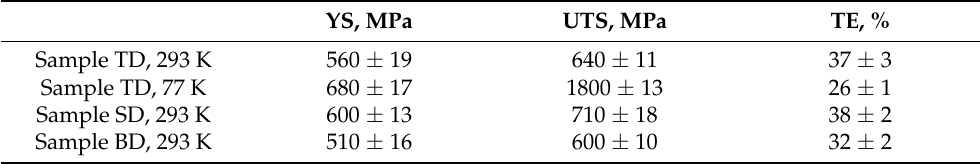
Table 3. Mechanical properties of the as-produced Fe 65 (CoNi) 25 Cr 9.5 C 0.5